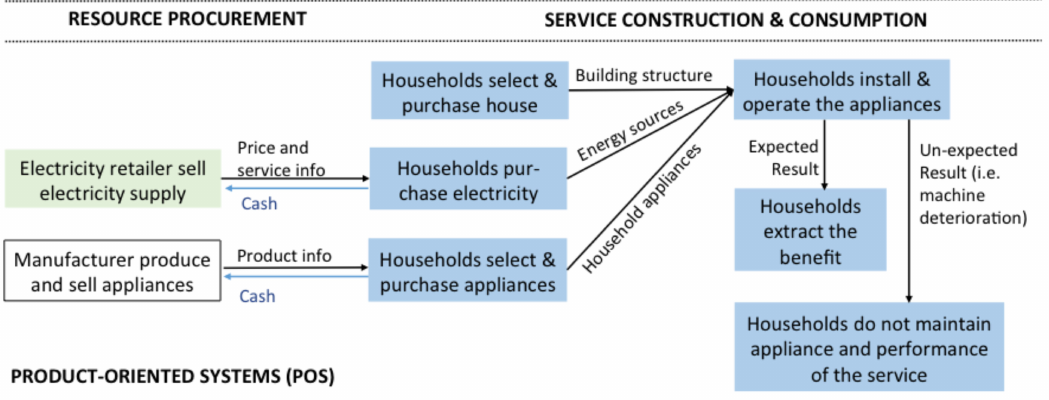
Figure 7. Product/Service and Cash Flow in